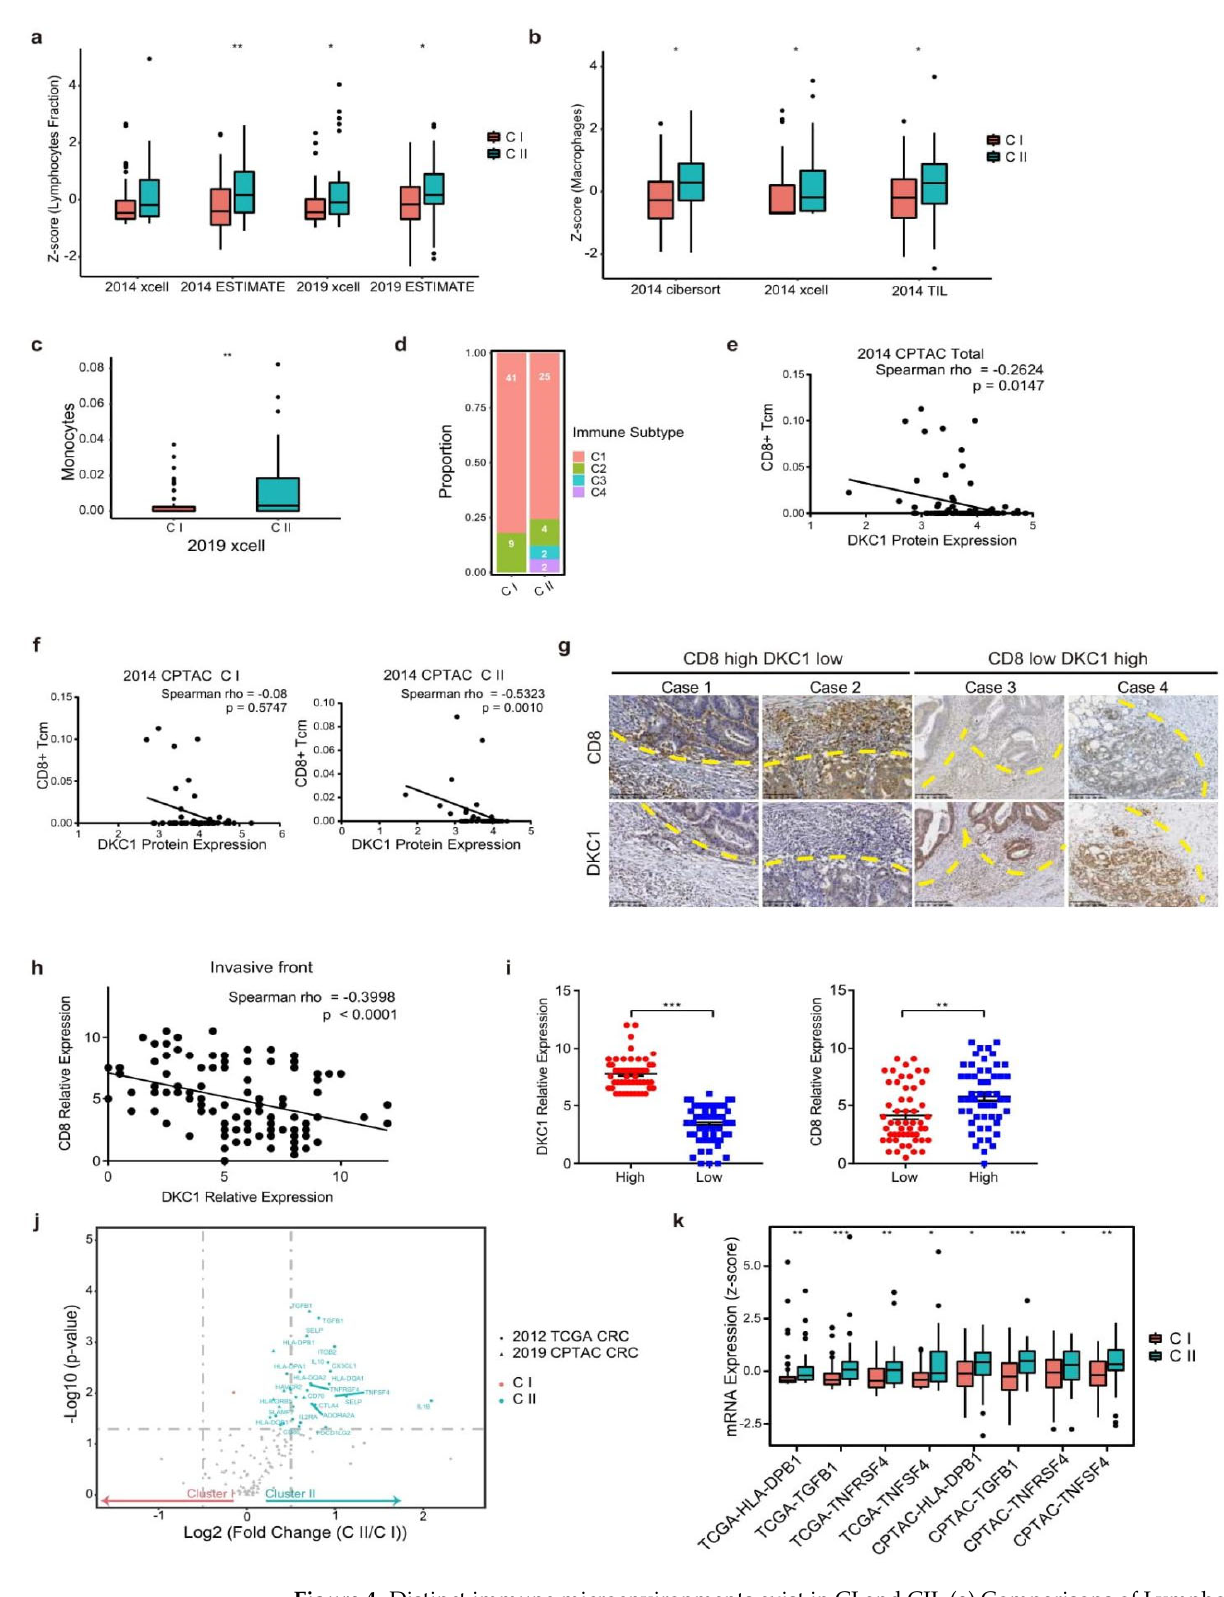
Figure 4. Distinct immune microenvironments exist in CI and CII. ( a ) Comparisons of Lymphocytes Fraction (see Section 4) between two clusters in two CRC databases by different immune faction analysis, xcell, and ESTIMATE [31,32]. ( b ) Comparisons of Macrophages between two clusters in 2014 CPTAC CRC databases analyzed by three methods, xcell, CIBERSORT, and immune staining of CRC databases [31,33,34]. ( c ) Comparisons of Monocytes between two clusters in 2019 CPTAC CRC Label free databases analyzed by xcell. ( d ) The distribution of patients belonging to two clus ‐ ters in four different immune subtypes from Thorsson et al., 2018, Immunity [35]. ( e ) Scatter diagram showing correlations of DKC1 protein expression with CD8+ Tcm cells in total patients in 2014 CPTAC CRC databases. ( f ) Scatter diagram showing correlations of DKC1 protein expression with CD8+ Tcm cells in CI or CII cluster in 2014 CPTAC CRC databases. ( g ) Representative images of